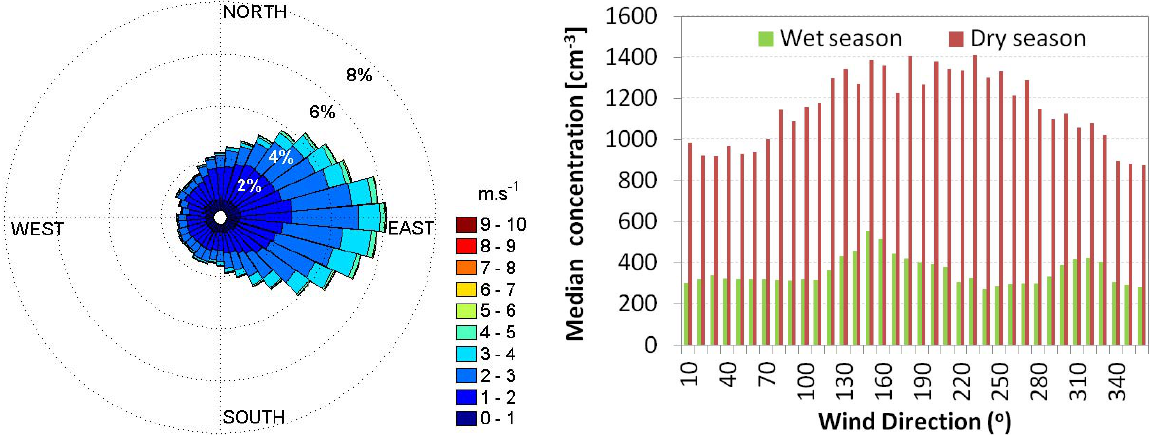
Fig. 3. (a) Wind rose plots for the period between January 2008 and June 2011. (b) Median aerosol particle number concentration as a function of wind direction for the wet season (January–June) and for the dry season (July–December). The Manaus city is located 60km away in the southeast